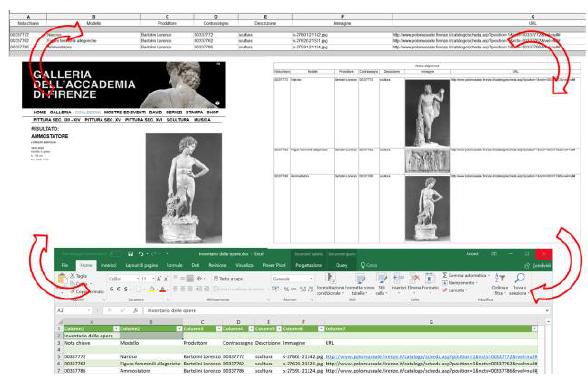
Figure 10. Data exchange between BIM schedules/quantities, external software and web